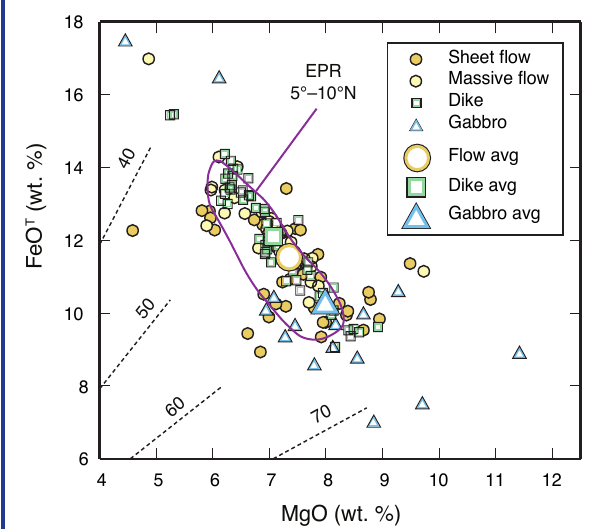
Figure 5. FeO T (Total Fe expressed as FeO) vs. MgO for the basement at Site 1256, compared with analyses of northern EPR. Dashed lines show constant Mg number. Possible primary mantle melt compositions should have Mg number of 70–78 and MgO of 9–14 wt. %. All flows and dikes and most gabbros are too evolved to be candidates for primary magmas (from Wilson et al., 2006).